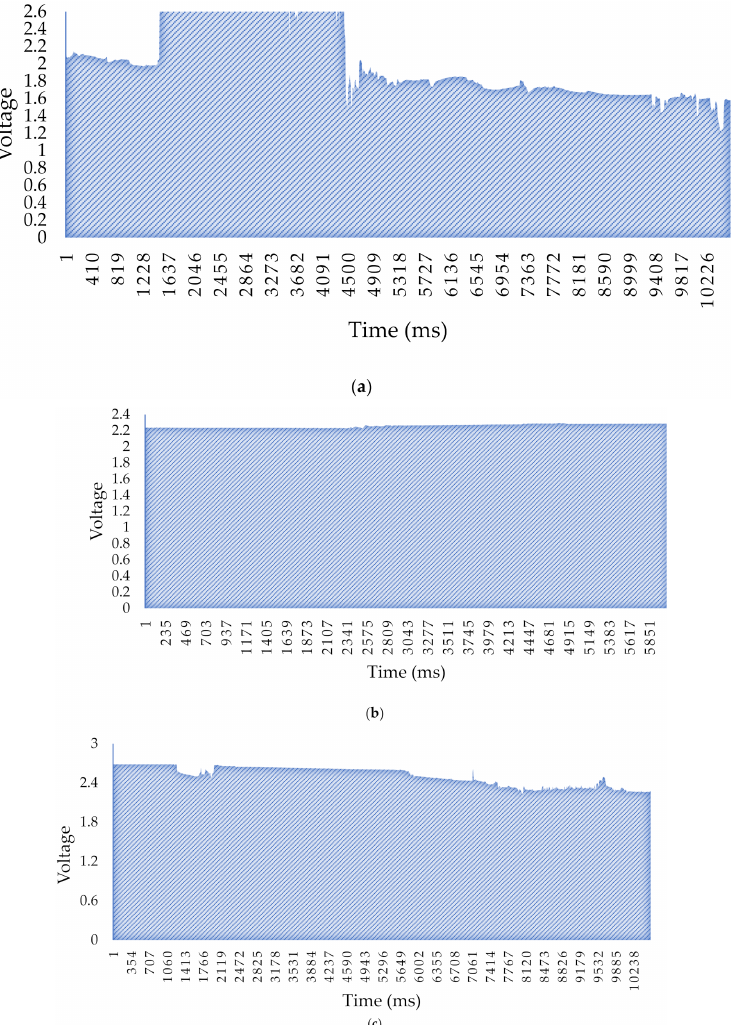
Figure 5. ( a ) Timer clock analysis of User ‘2’; ( b ) Video analysis of User ‘2’; ( c ) Reading analysis of User ‘2’.